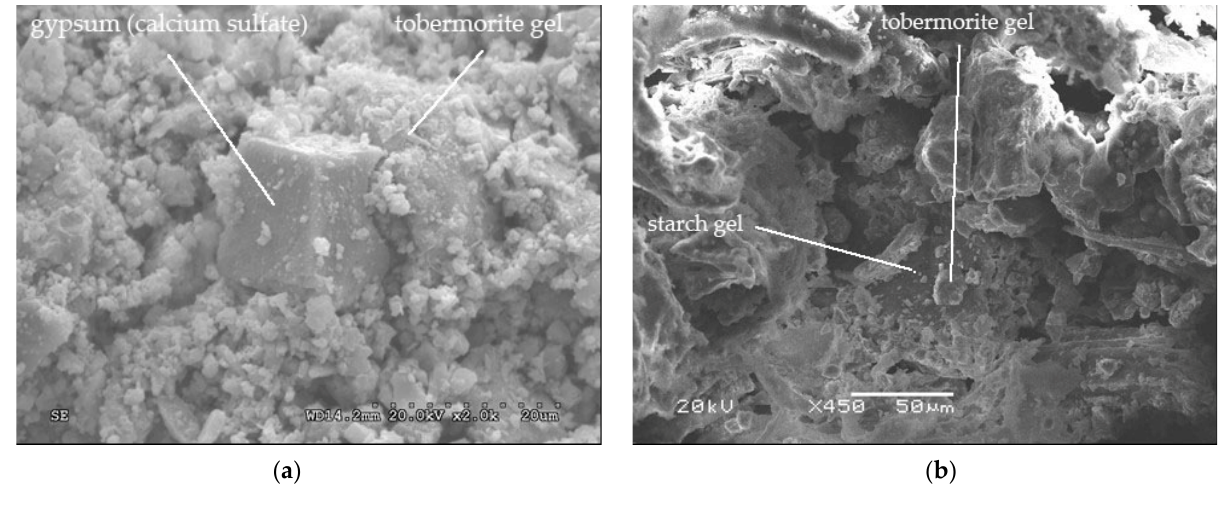
Figure 9. ( a ) Gypsum cube surrounded by tobermorite gel 3 days after hydration and ( b ) tobermorite over an organic gel 8 days after hydration.